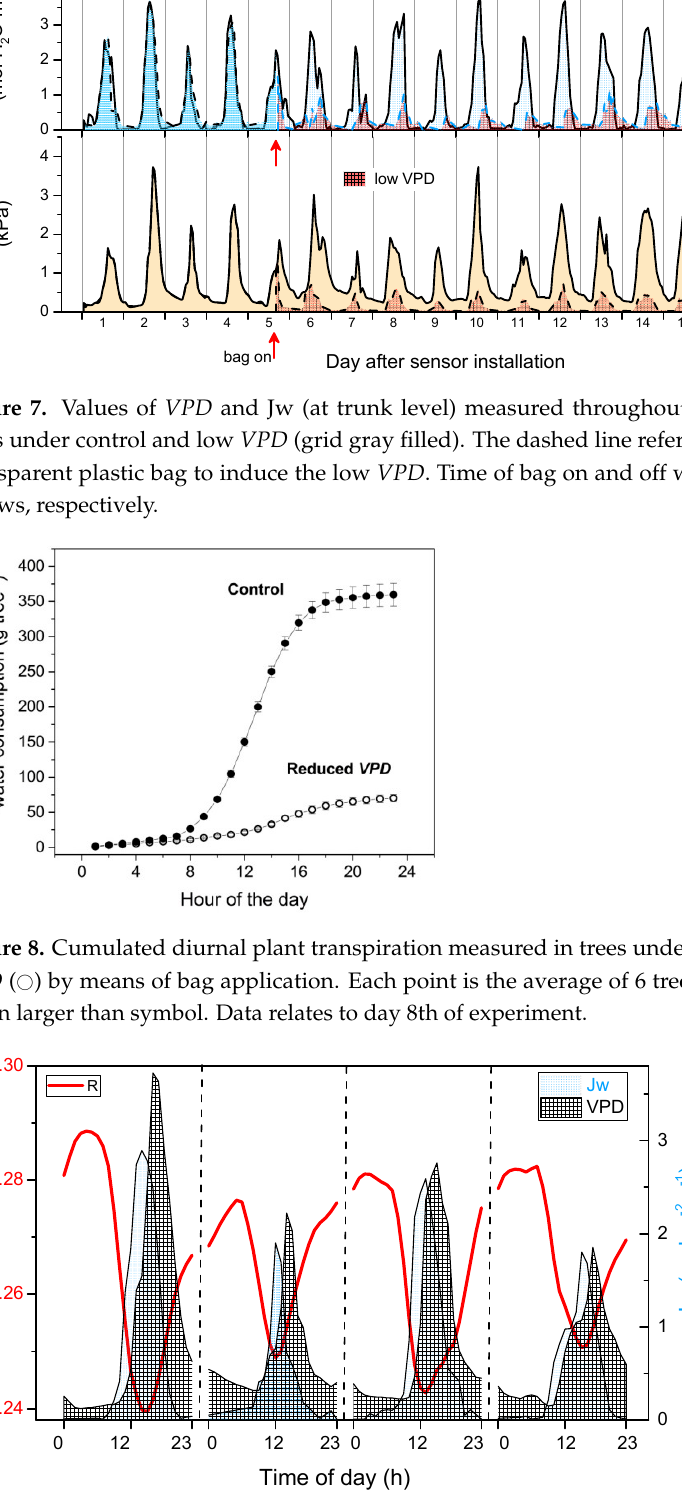
Figure 9. Oscillation of diurnal bioristor signal R (continuous line), water flux density Jw (blue filled area) and VPD (grid filled area) recorded over 4 consecutive days separated by vertical dashed lines. 0.30